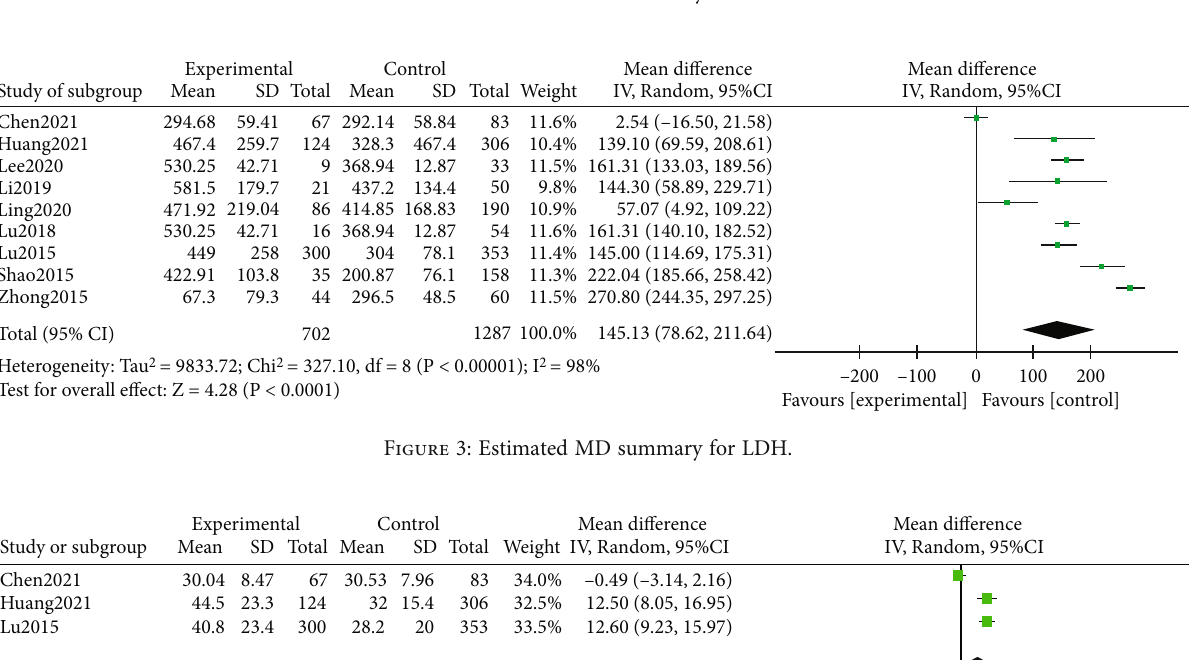
Figure 2: Estimated MD summary for CRP.